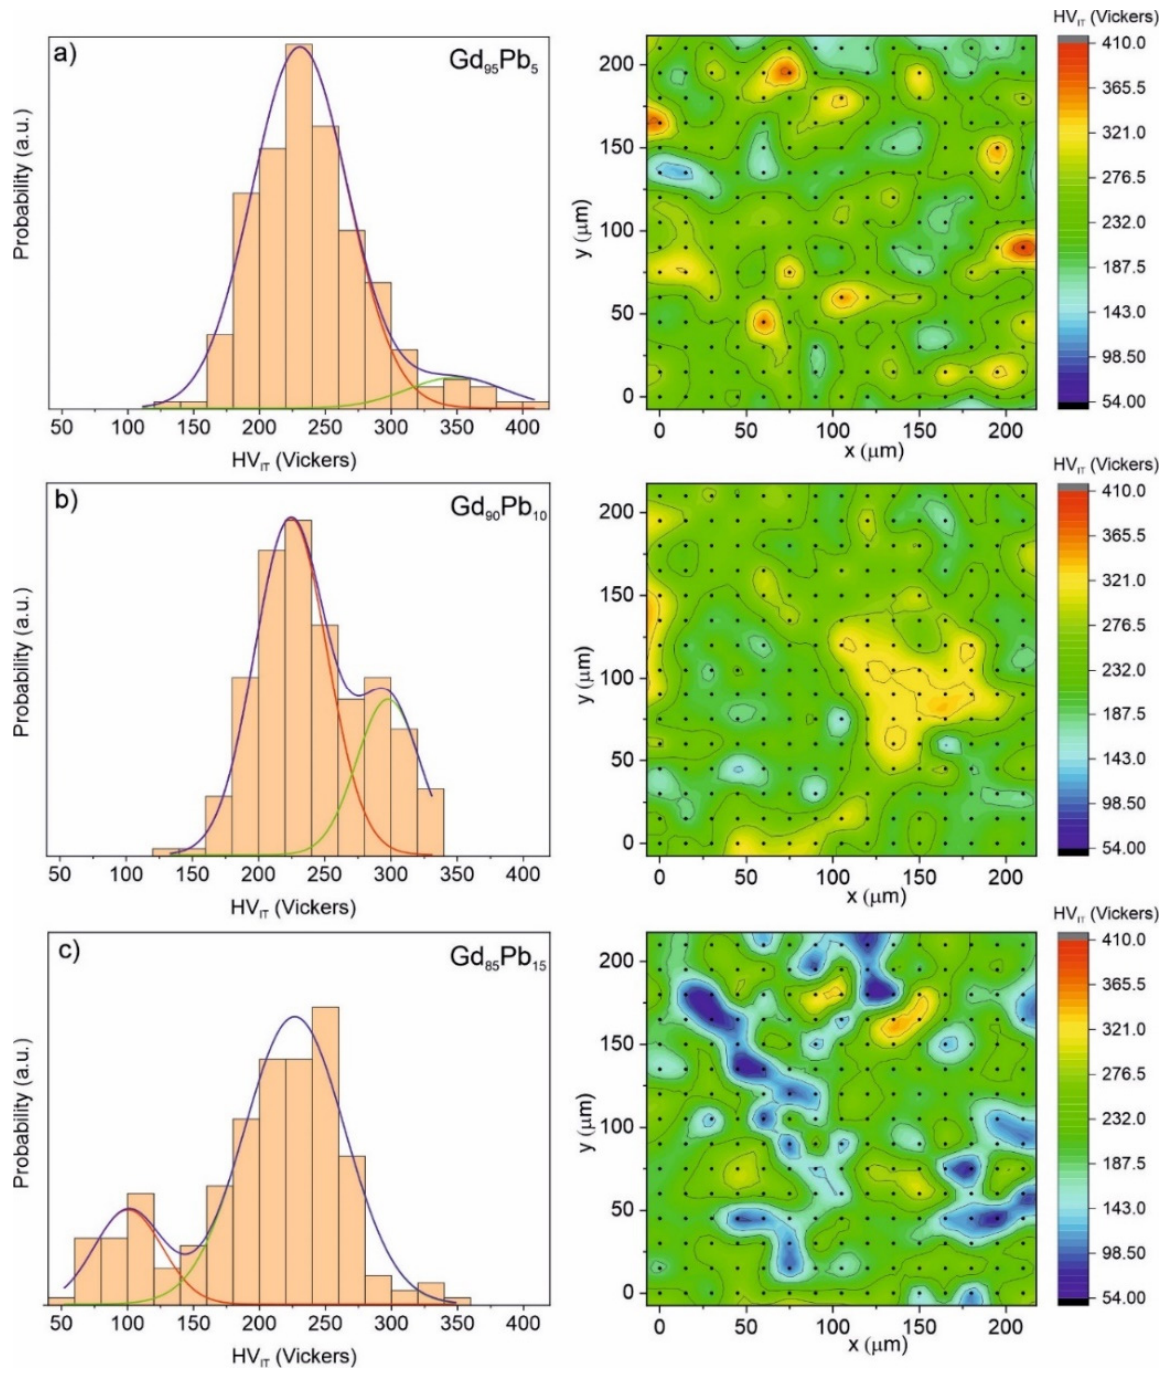
Figure 8. Distributions of hardness HV IT with corresponding 2D mapping graphs obtained from nanoindentations test for the Gd 95 Pb 5 ( a ), Gd 90 Pb 10 ( b ) and Gd 85 Pb 15 ( c ) alloys. The dots marked on the map distributions (left side) correspond to the locations of measurements.